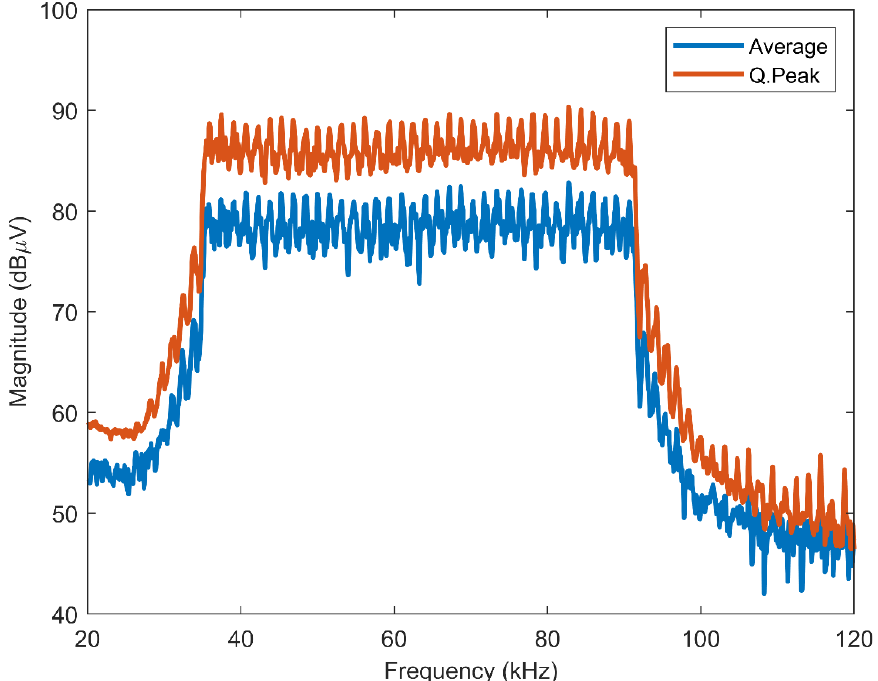
Figure 4. Frequency spectrum of the exploited G3-PLC signal. PWM/RPPM can be easily implemented using a microcontroller and SIMULINK.